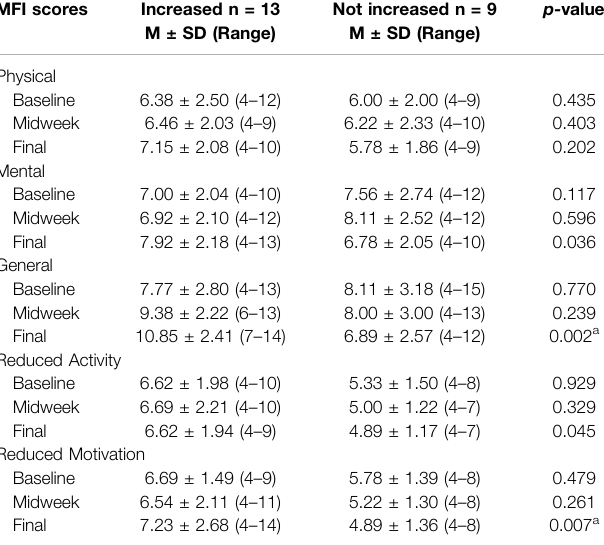
a Indicates signi fi cance following Bonferroni-Holm correction for multiple comparisons.